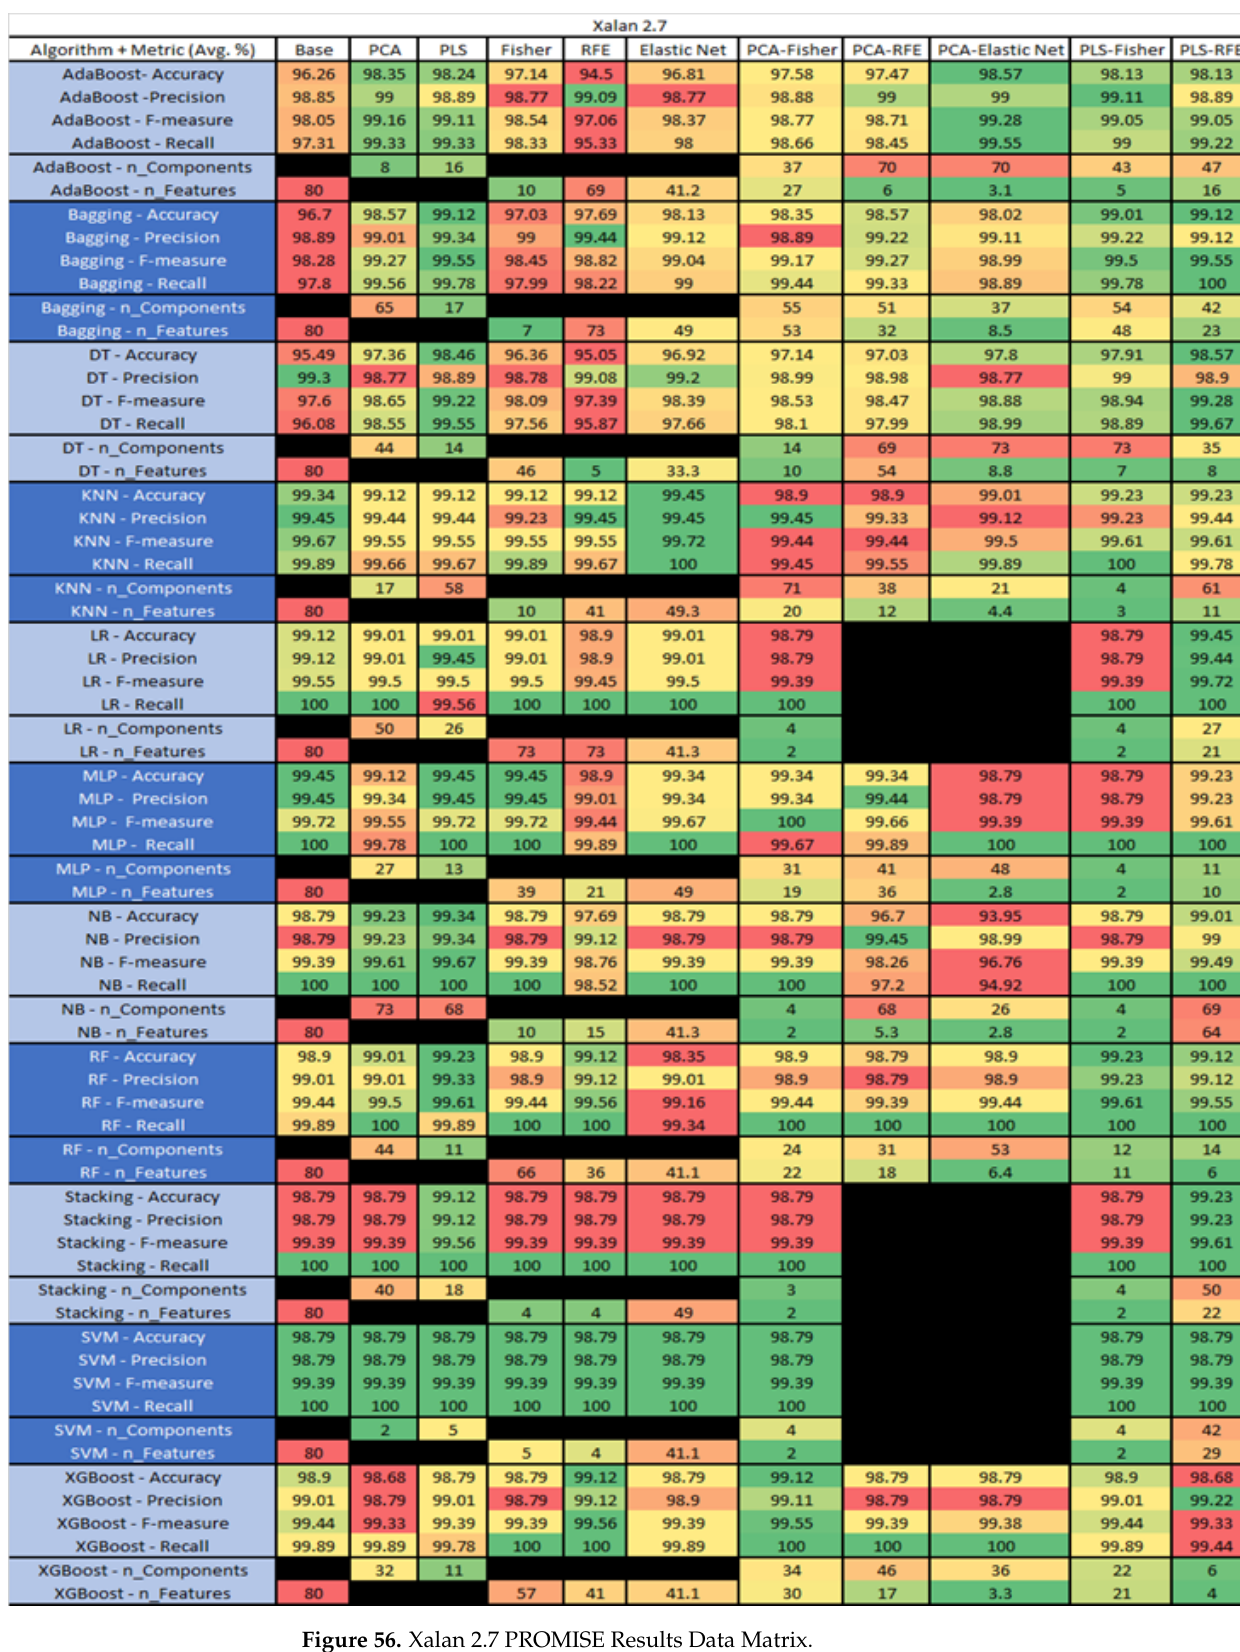
Figure 56. Xalan 2.7 PROMISE Results Data